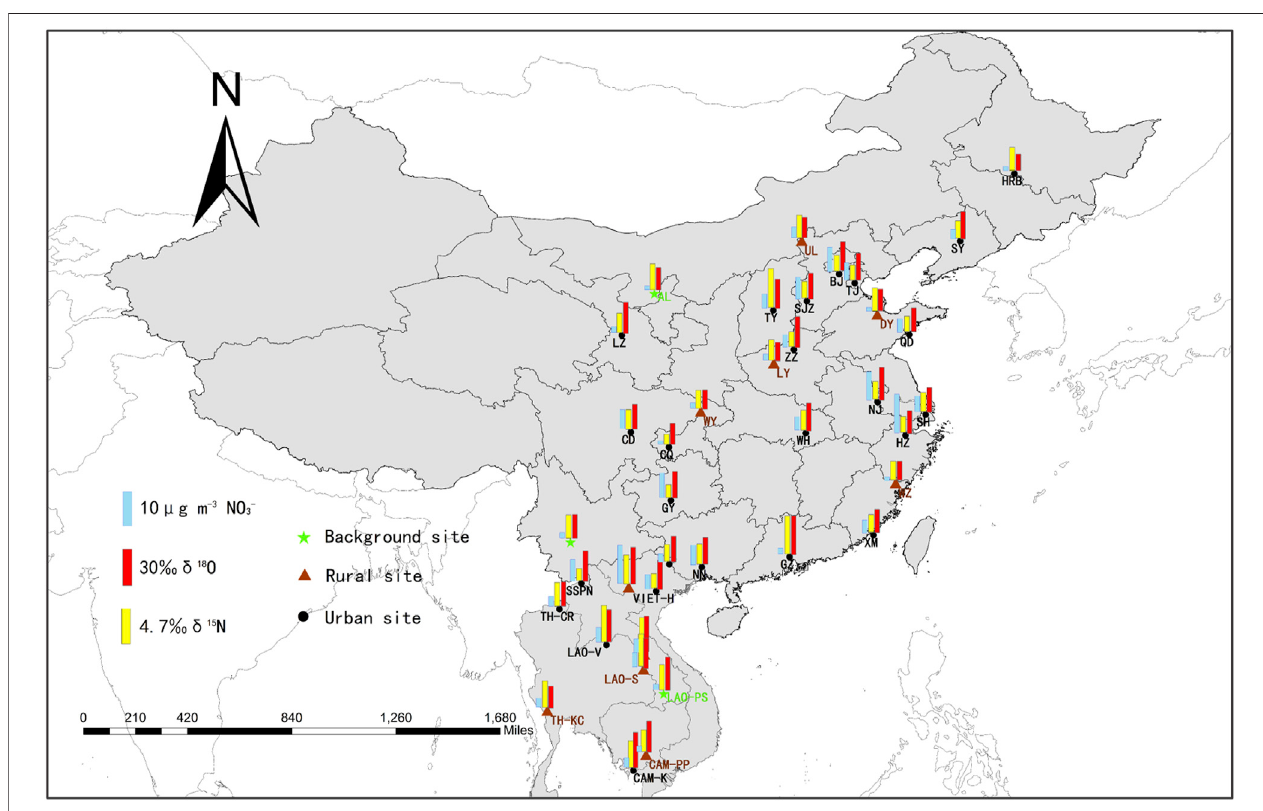
FIGURE 2 | Spatial distribution of NO 3 − concentrations, δ 15 N, and δ 18 O in 38 sampling sites of the CICP. The NO 3 − concentrations, δ 15 N, and δ 18 O values are indicated by blue, yellow, and red bar, respectively.